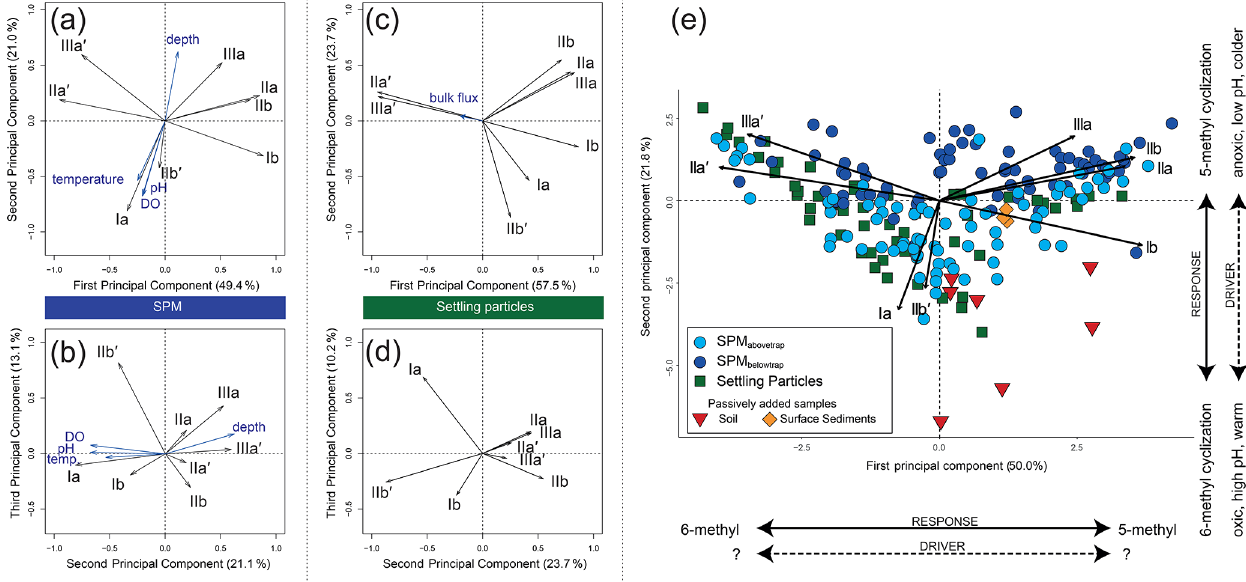
Figure 6. Principal component analysis (PCA) of the fractional abundances of the eight major brGDGTs in SPM ( n = 143) and settling particles ( n = 53) from Lake Chala. (a–b) PC1 vs. PC2 (a) and PC2 vs. PC3 (b) of the SPM samples, with black vectors indicating the PCA scores of individual brGDGTs, and blue vectors showing the PCA scores of environmental variables added passively. Temperature and pH are measured (0–50m depth, van Bree et al., 2018) and assumed constant from 50 to 80m depth. (c–d) PC1 vs. PC2 (c) and PC2 vs. PC3 (d) of the settling particles, with black vectors indicating the PCA scores of individual brGDGTs, and the blue vector showing the PCA score of the total bulk settling flux added passively. (e) Combined PCA of the fractional abundances of the (mainly aquatic) brGDGTs in all SPM (blue circles) and settling-particle (green squares) samples, with distinction between SPM from above (light blue) and below (dark blue) the sediment trap. The PCA scores of lake sediments (orange diamonds) and soils (red triangles) were added